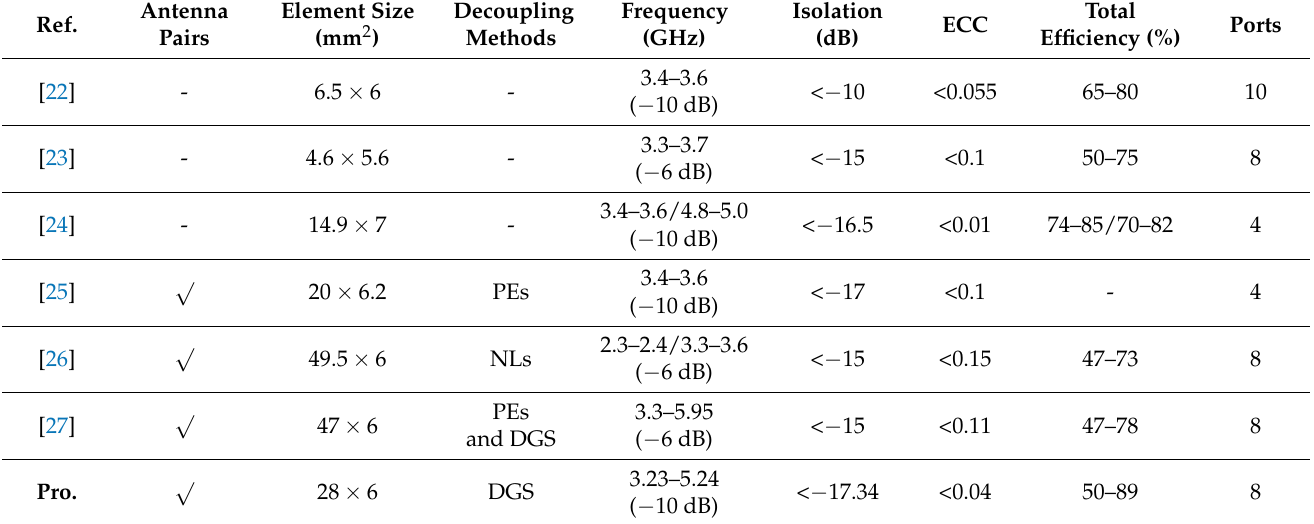
Table 1. Comparisons of MIMO terminal antenna